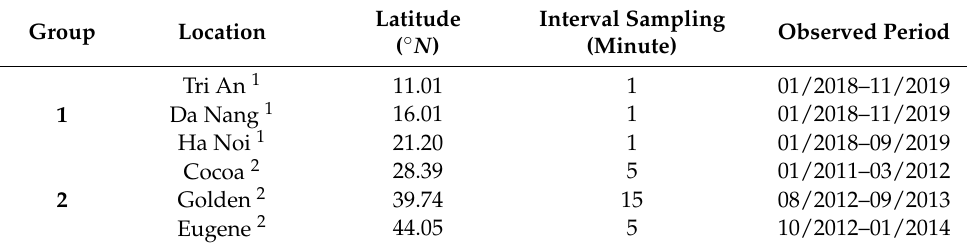
Table 1. Selected databases for training and validating models. Group